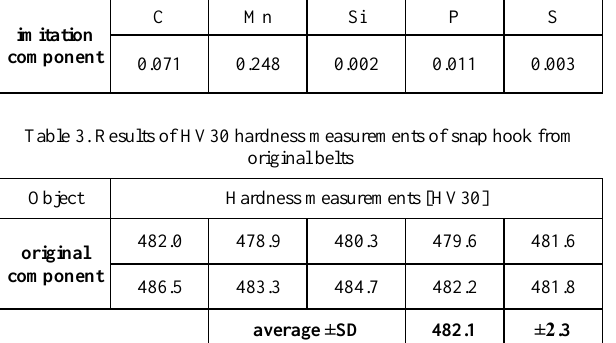
Table 2. Results of spectral analysis of the chemical composition of snap hook from belts imitating the original Object Chemical composition [wt.%]